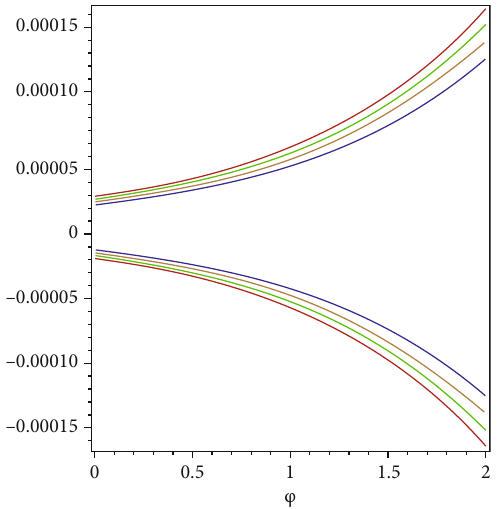
Figure 4: The two-dimensional fuzzy lower and upper branch graph of the di ff erent fractional-order of ϱ